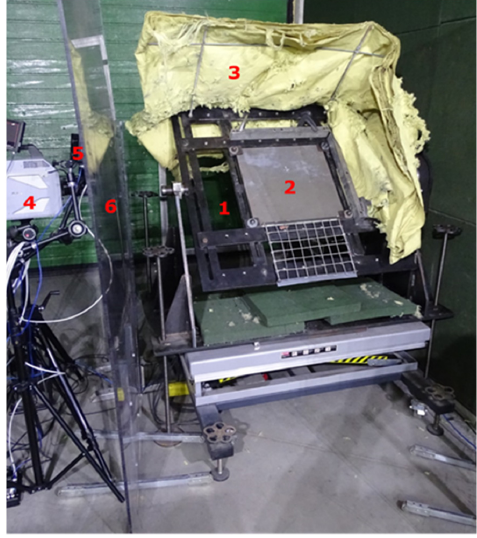
Figure 1. Temperature test stand for ricochetting projectiles. 1, stand; 2, 500 × 500 × 10 mm Armox 600 plate; 3, aramid fabric; 4, Photron Fastcam SA-Z 2100K high-speed camera; 5, lighting; 6, camera and lighting covers.